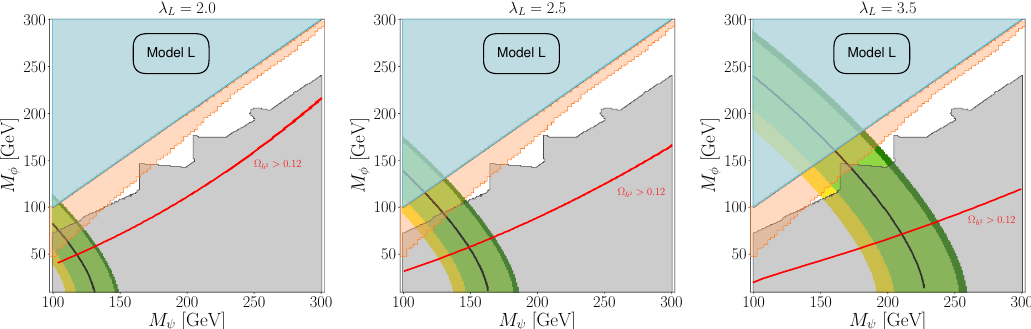
Figure 5. Results from Model L, scanning over the masses of the new fermion and scalar which couple to the left-handed muon. Regions which can explain ∆ a in eq. (1.7) or eq. (1.6) to within µ 1 σ are coloured green and yellow respectively, with the overlap between the two regions is coloured lime. The black line indicates masses which produce a ∆ a contribution matching eq. (1.7). The µ points where a dark matter candidate particle produces the observed relic abundance of 0 . 1200 , eq. (1.8), are shown in red, with the region below being excluded due to having an over abundance of dark matter. The region where M is shaded cyan. Regions excluded by 13 -TeV results ψ < M φ at the LHC are shaded grey, with the exclusions from the soft leptons search [482] obtained using CheckMate shaded in orange. Thus a µ can only be explained in small slices of parameter space between the grey and orange regions. As the coupling between the left-handed muon and the BSM particles is increased, higher masses are required to explain a µ